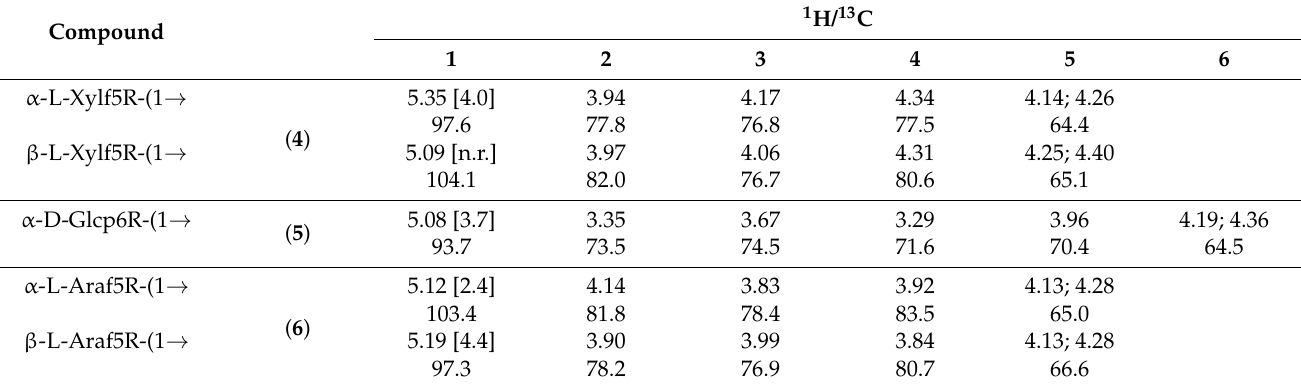
Table 1. 1 H and 13 C NMR chemical shifts (ppm) of the monosaccharide moiety of the lauroyl derivatives (compounds 4 , 5 and 6